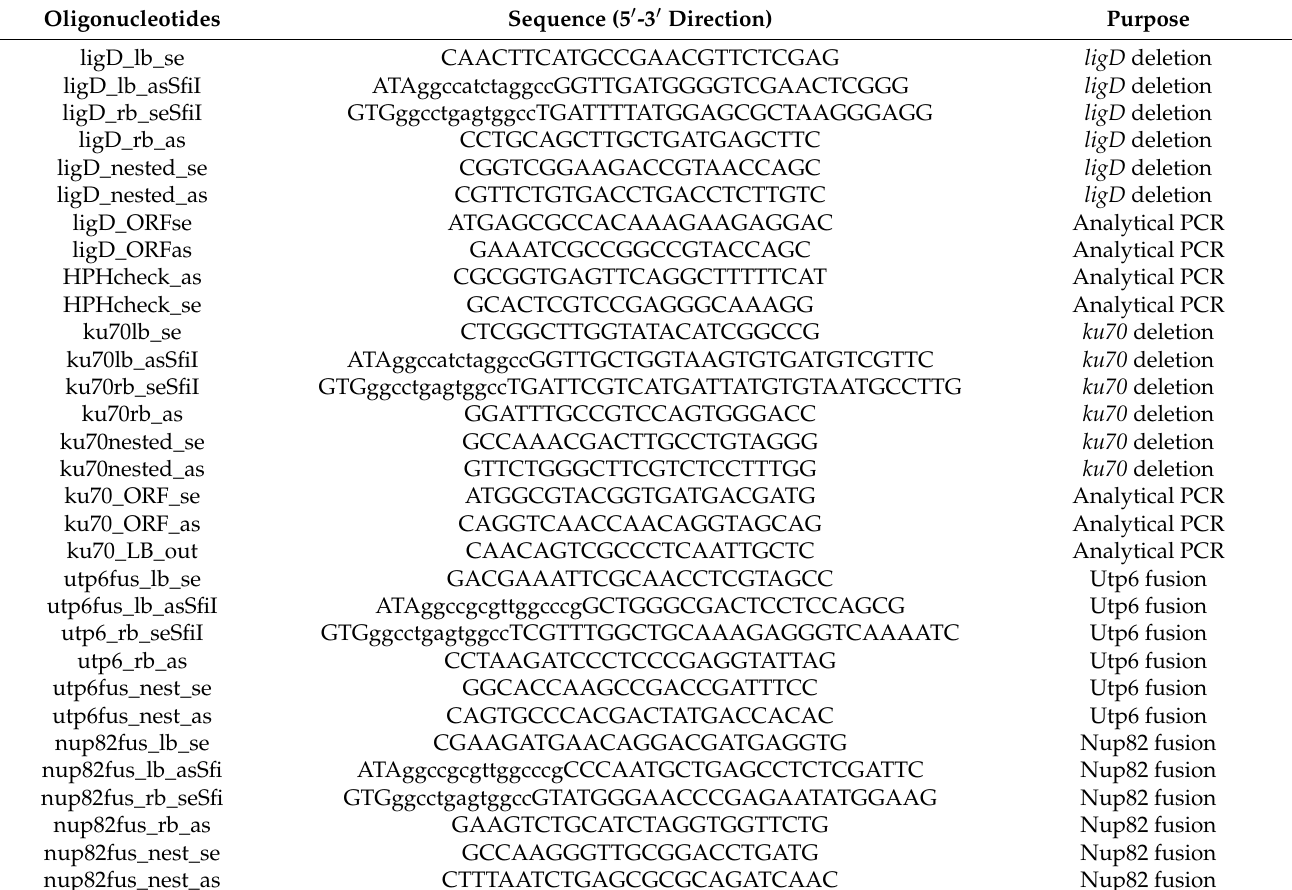
Table 2. Oligonucleotides used in this